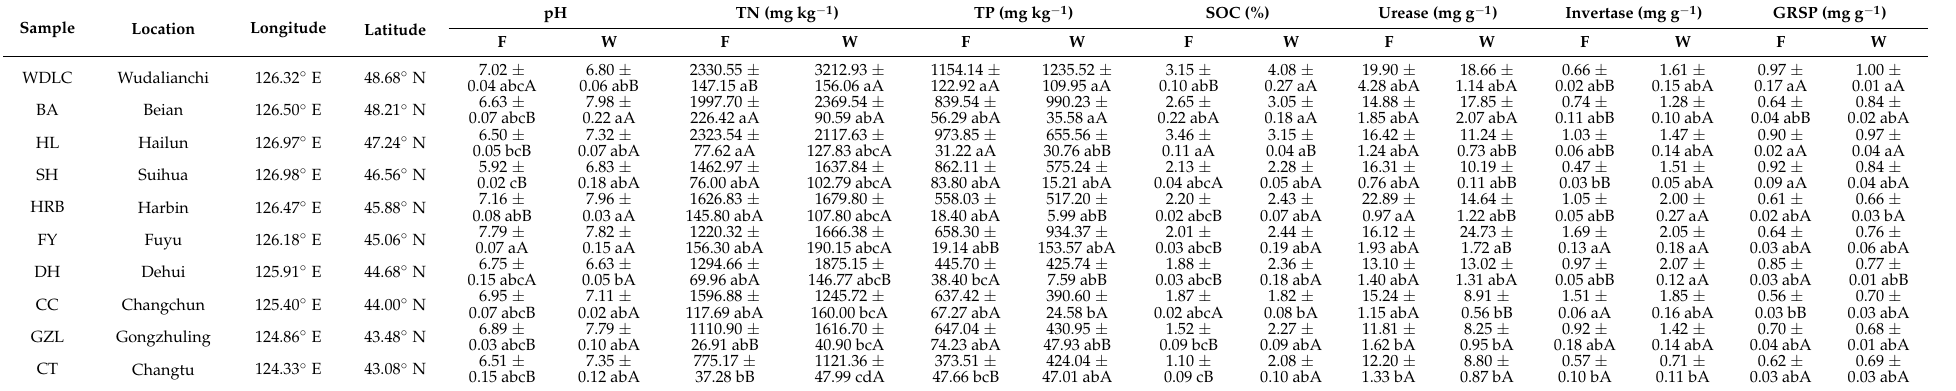
Table 1. Sampling site location information and edaphic factors. The value of edaphic factors is mean ± standard